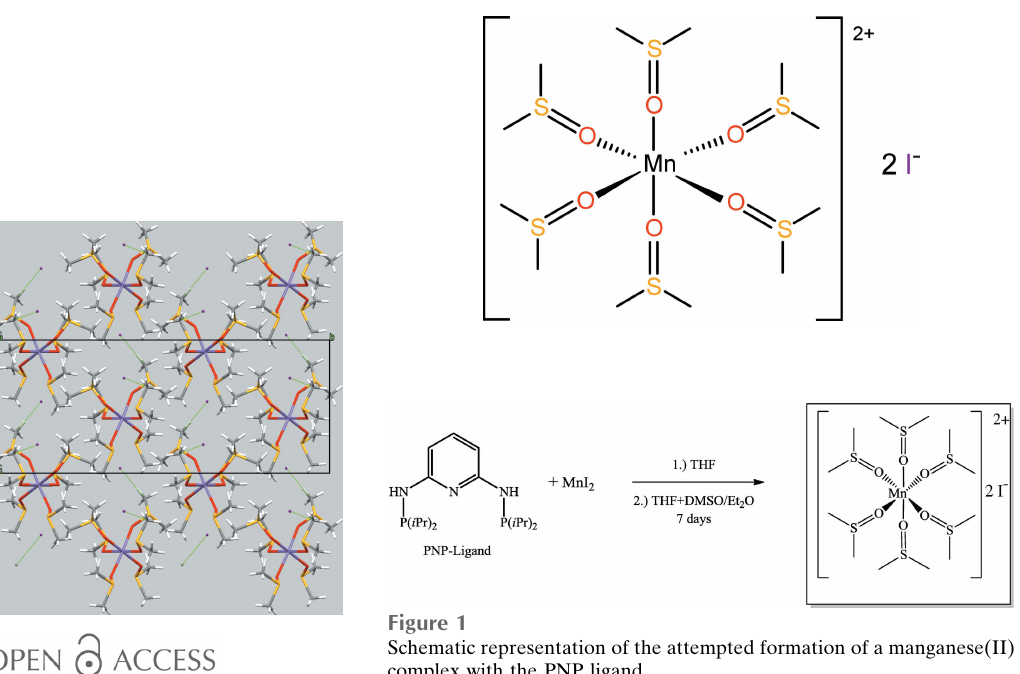
Figure 1 Schematic representation of the attempted formation of a manganese(II) complex with the PNP